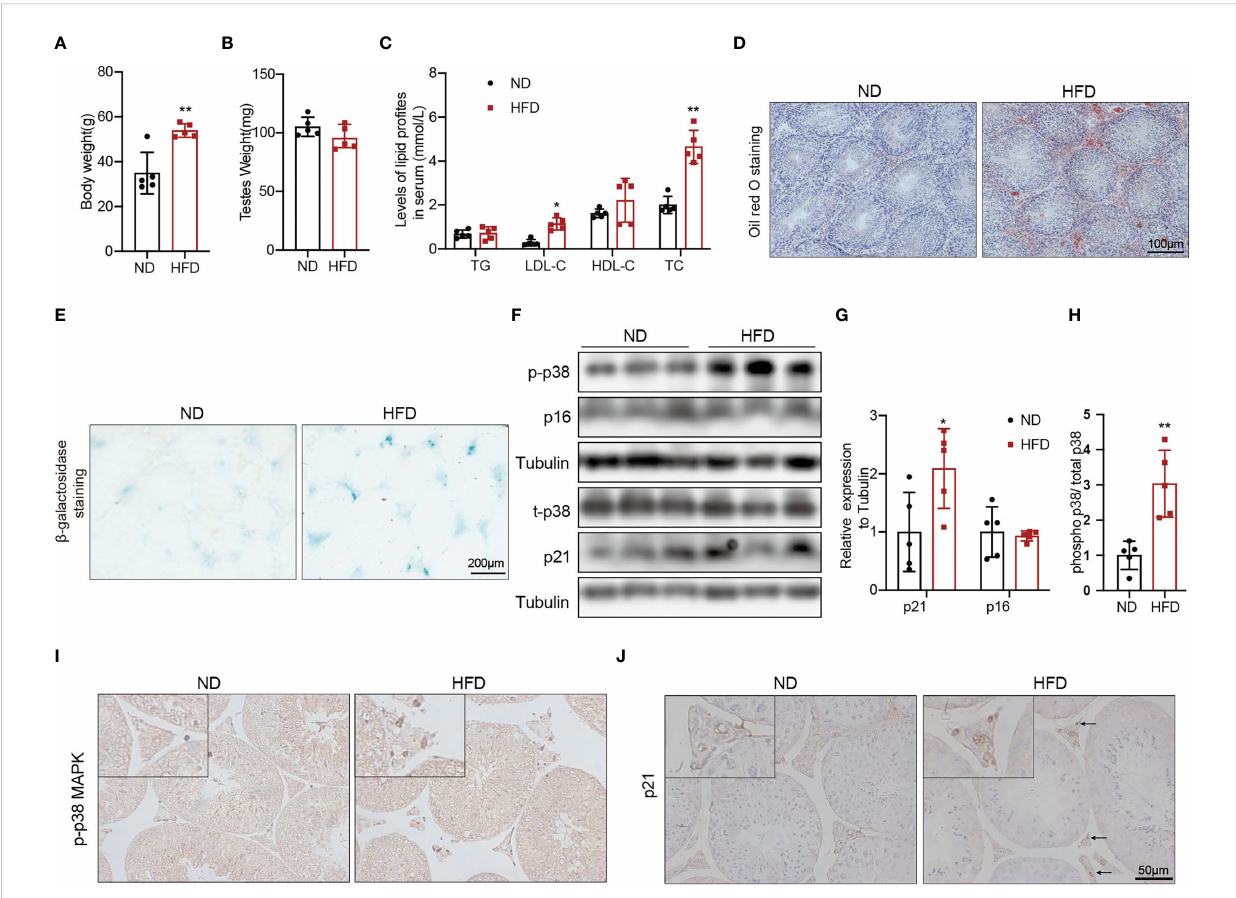
FIGURE 3 The aging status and p-p38 MAPK level of Leydig cells in mice fed with HFD or ND for 24 weeks. Body weight (A) , testis weight (B) , and serum lipid levels (C) were evaluated for mice. Lipid deposition in testicular tissues was detected by oil red O staining (D) . Aging status of Leydig cells was assessed by SA- b -Gal staining (E) . Immunoblot was used to detect the levels of p16, p21, and p-p38 MAPK (F) . Quantitative analysis for protein level (G, H) . IHC staining of p21 (I) and p-p38 MAPK (J) in testis tissue. *p<0.05,